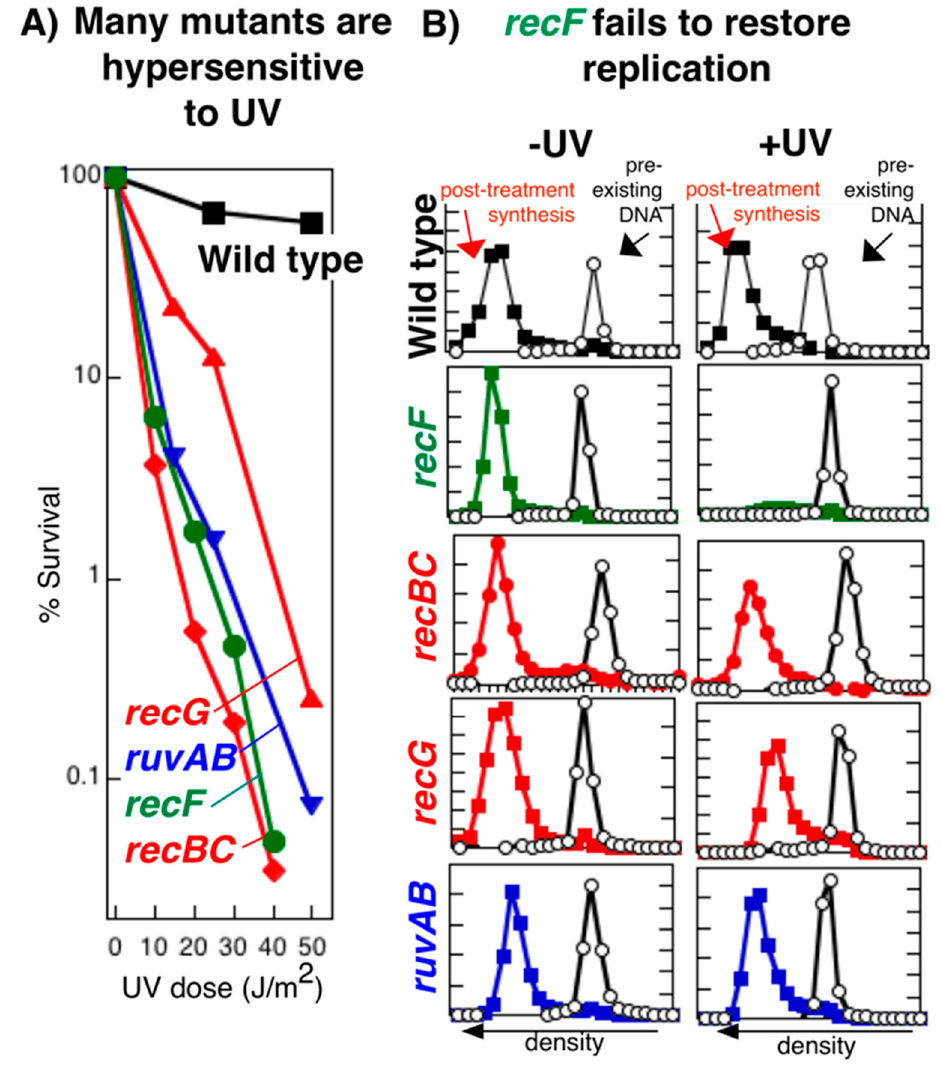
Figure 11. Restoring replication after disruption is specific to the recF pathway. ( A ) recF, recBC, ruvAB, and recG mutants all exhibit high levels of cell lethality following UV-induced DNA damage. The survival of UV-irradiated wild-type, recF , recBC , ruvAB , and recG cells at the doses indicated is plotted. ( B ) Yet only recF mutants fail to restore replication after UV-induced damage. The amount of DNA synthesized during a 1 h period in UV-irradiated (25 J/m 2 ) or mock-irradiated cultures was determined by density labeling the DNA with 5-bromodeoxyuridine and subsequent isolation in isopycnic alkali CsCl gradients. Open circles, DNA synthesized before treatment ( 14 C); filled squares, DNA synthesized following treatment ( 3 H). The range of 3 H and 14 C axes was kept constant for each strain. Redrawn from data presented in [91,164,165].